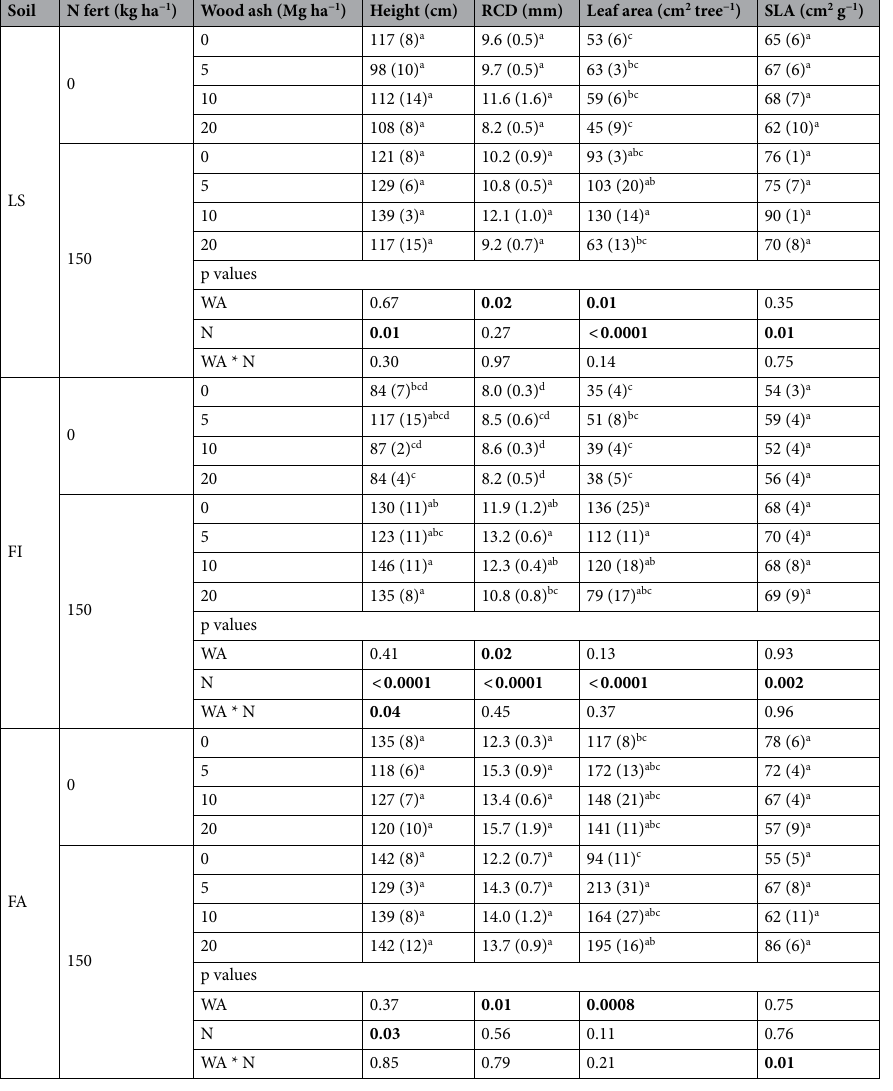
Table 2. Growth of Zelkova serrata seedlings applied with four levels of wood ash (WA; 0, 5, 10, and 20 Mg ha −1 ) and two levels of N fertilizer (N fert; 0 and 150 kg ha −1 ) across three different soil types (LS, landfill saline soil; FI, forest infertile soil; FA, forest acidic soil) at the end of this study (20 weeks after treatment). RCD, root collar diameter; SLA, specific leaf area. Standard errors are shown in parentheses (n = 5). P values are from the result of two-way ANCOVA with initial RCD of seedlings as the covariate to detect the effect of wood ash and N fertilizer on height, RCD, leaf area, and SLA within each soil type. Significant p values are in bold. Different lower case letters within each soil indicate significant differences (p < 0.05, Tukey–Kramer comparison lines for least squares means) in each growth property across four wood ash levels and N fertilizer